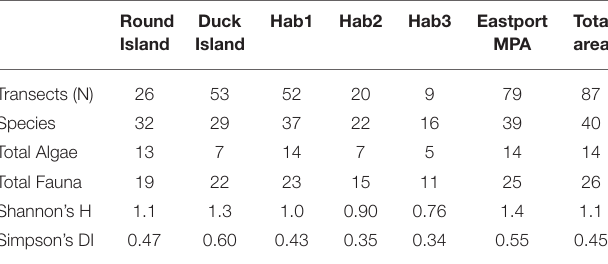
TABLE 2 | Species Richness and Diversity (Shannon’s H and Simpson’s Diversity Index calculated for fauna only). Round Duck Hab1 Hab2 Island Island